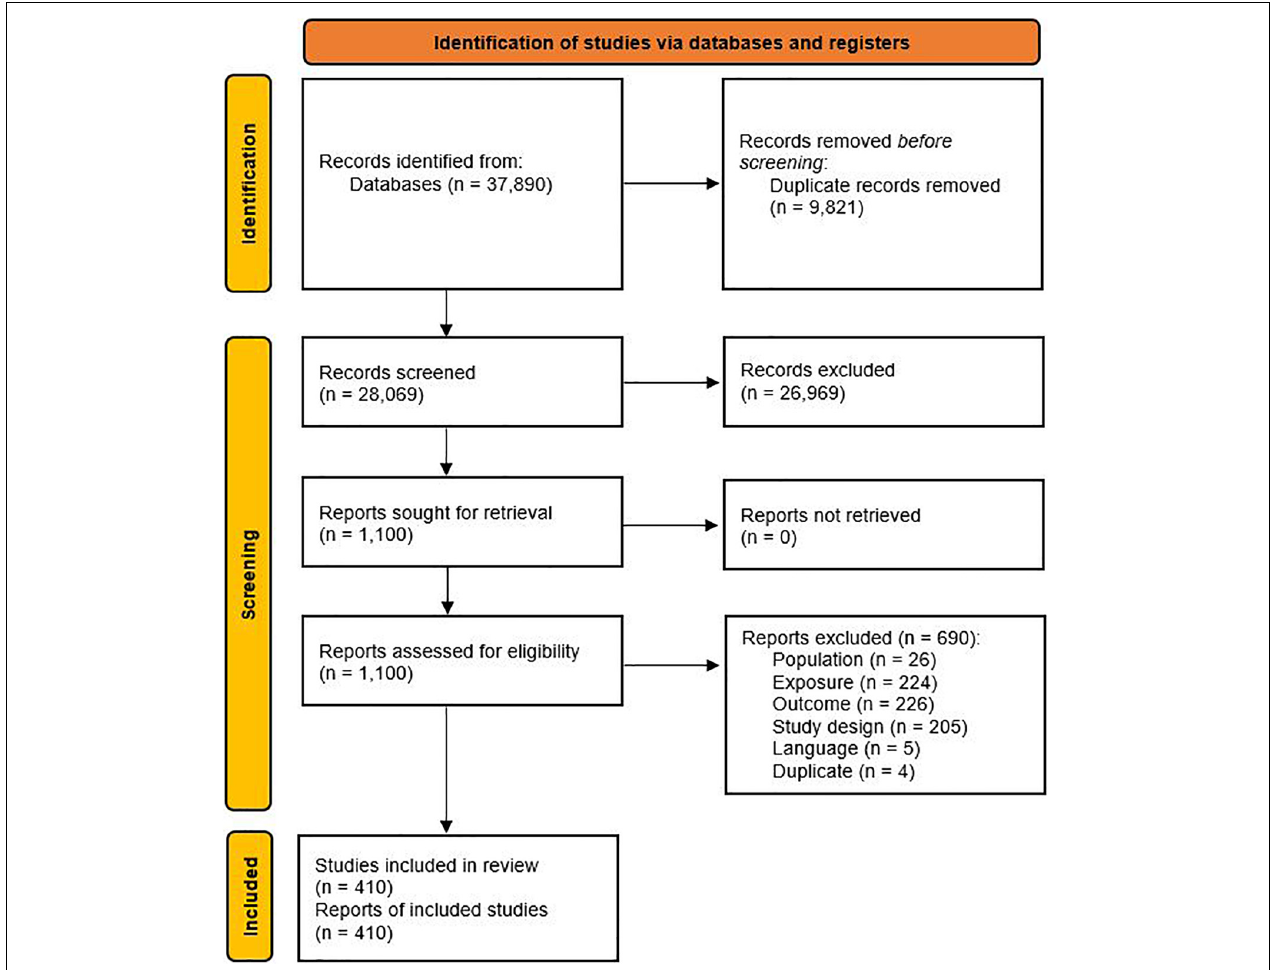
FIGURE 1 | Study selection flow